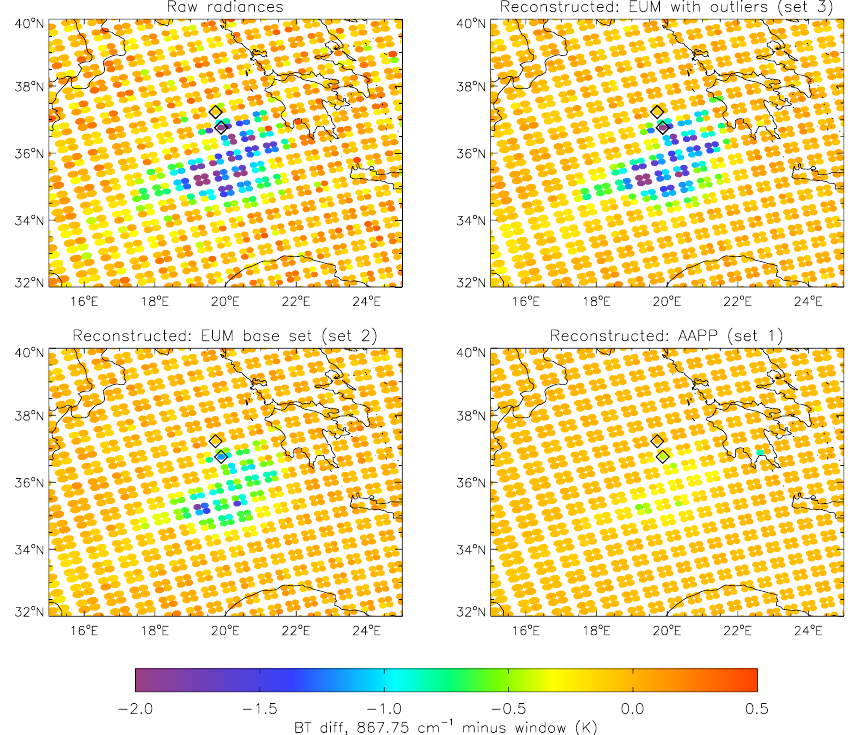
Fig. 1. Ammonia signal associated with biomass burning near Greece on 25 August 2007, 19:38 MetOp overpass. The brightness temperature at 867.75cm − 1 has been subtracted from the brightness temperature in adjacent window channels. Shown for raw radiances and three varieties of reconstructed radiances. The BT scale has been fixed at − 2.0 to +0.5K in order to show background noise, but it should be noted that the strongest signal was − 3.7K. The size of the IASI spots has been increased from 12km at nadir to 20km in order to show colours clearly. The spots selected for display in Fig. 2 are marked by black